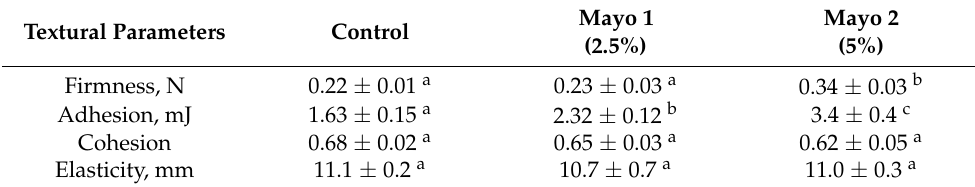
Table 8. Textural characteristics of value-added mayonnaise. Textural